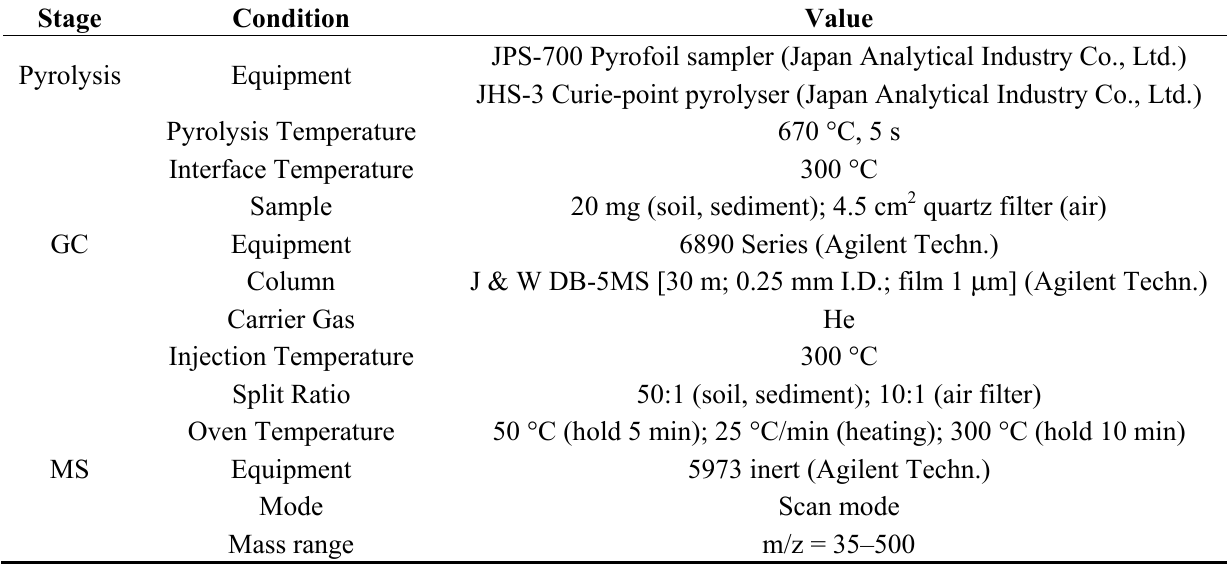
Table 2. Summary of pyrolysis-GC/MS